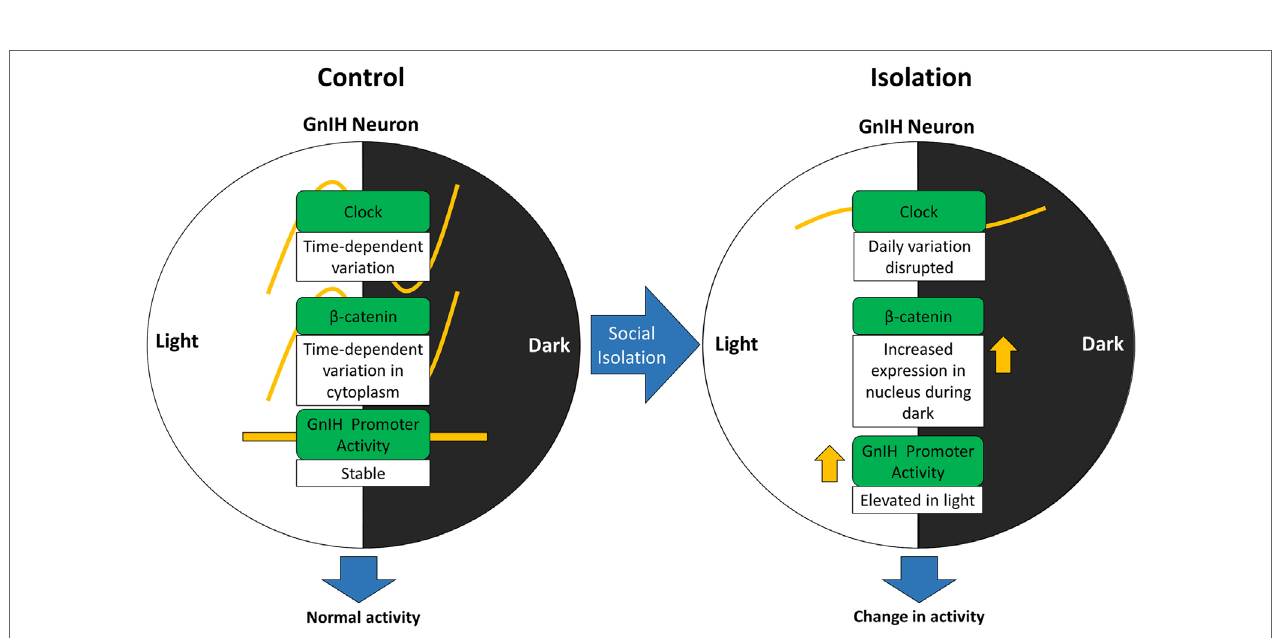
FigUre 6 | Colocalization of β -catenin within gonadotropin-inhibitory hormone (GnIH) neurons in the dorsomedial hypothalamus (DMH) region across different time points. β -catenin immunostaining (red) was observed within GnIH neurons (green) in (a) control at ZT12, (B) control at ZT18, (c) isolation at ZT12, and (D) isolation at ZT18. Scale bar = 25 µm. White arrows indicate cytoplasmic colocalization, while white arrowheads indicate colocalization within or around the nucleus of GnIH